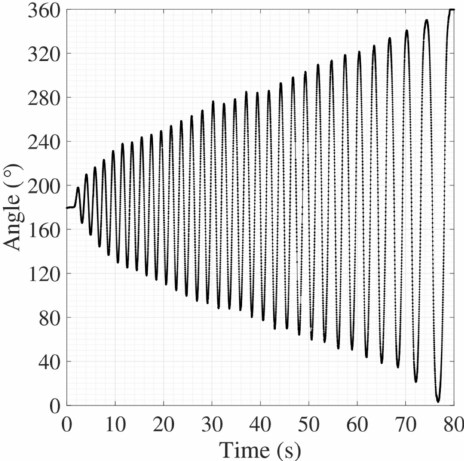
Figure 9. The ringing up of bell number ten of mass 1425 kg in Durham